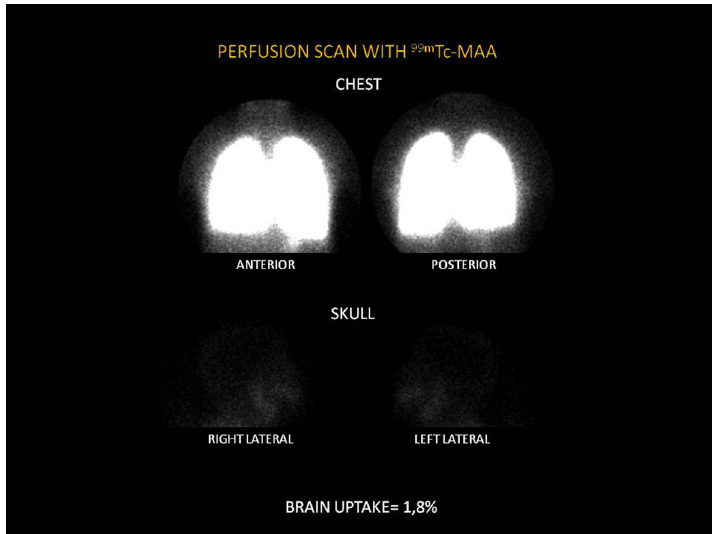
Figure 2. Normal scintigraphy. Brain uptake=1.8%.